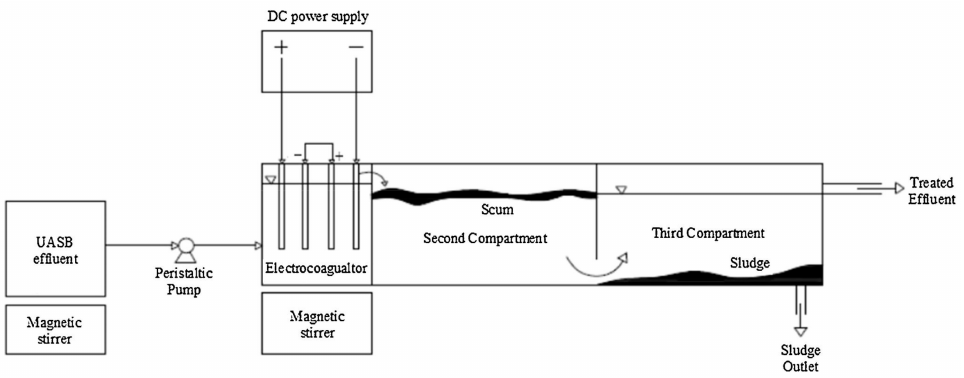
Figure 15. Experimental set-up